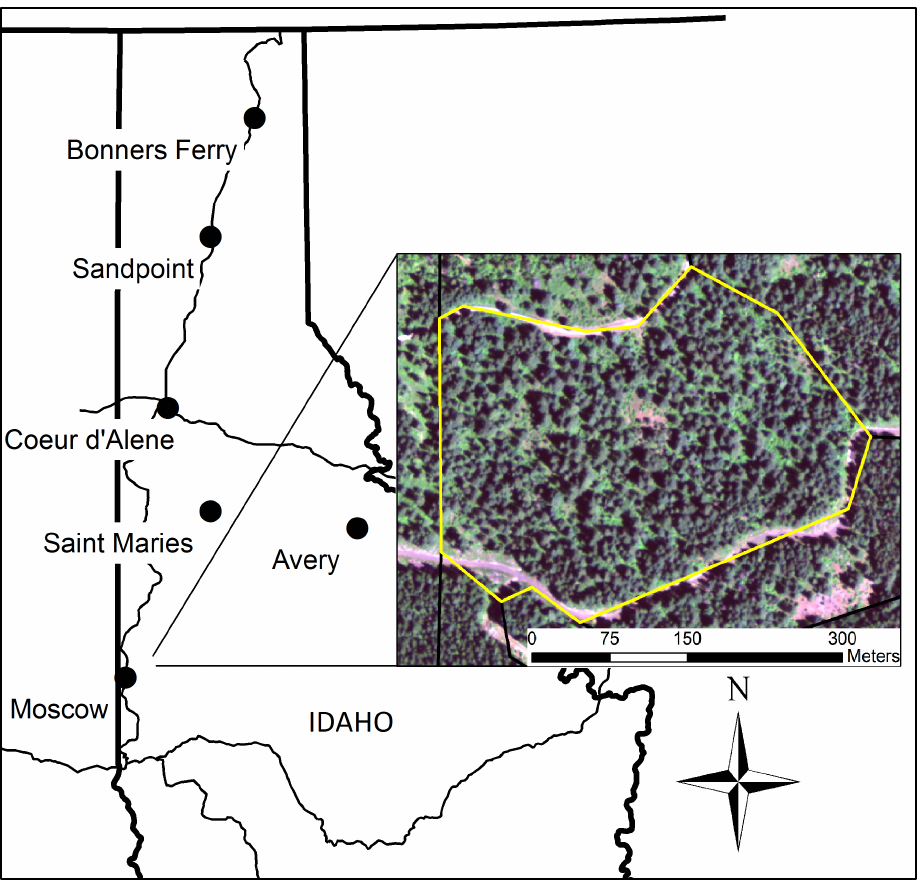
Figure 1. The study unit located Northeast of Moscow, Idaho in the West Hatter Creek Unit